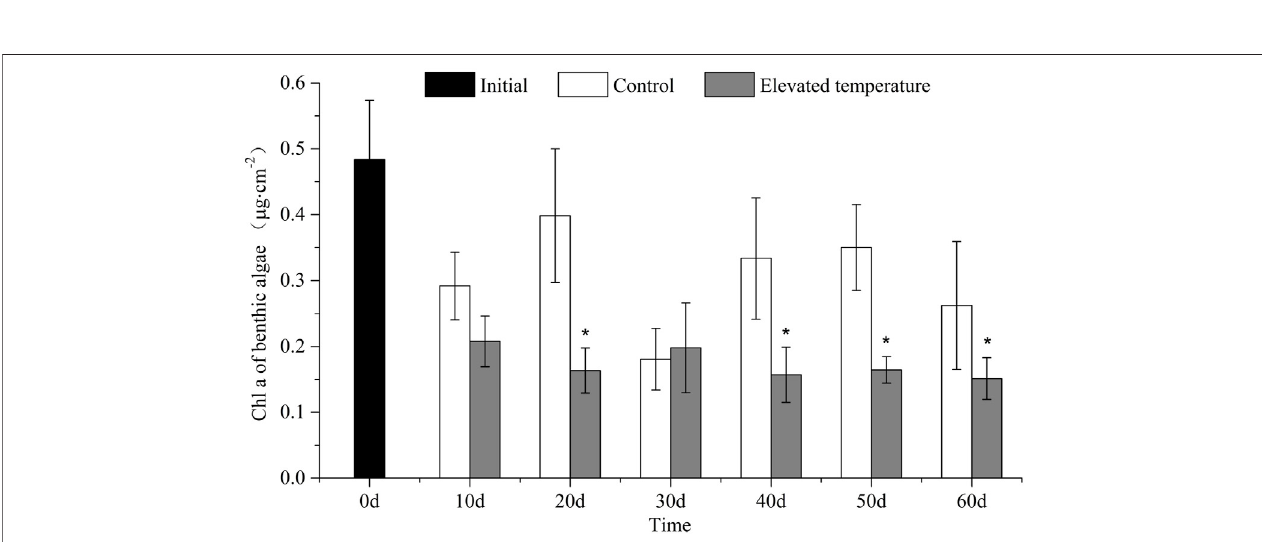
FIGURE 4 | Chl a of benthic algae (mean ± SD) in different treatments over time. Asterisk indicates signi fi cant ( p < 0.05) differences between treatments.